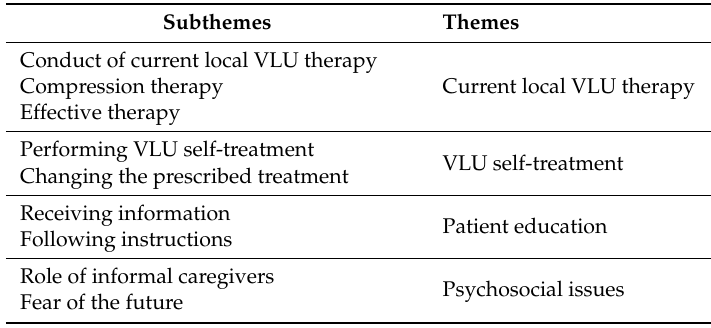
Table 2. Overview of the subthemes and themes describing the experiences of VLU patients with